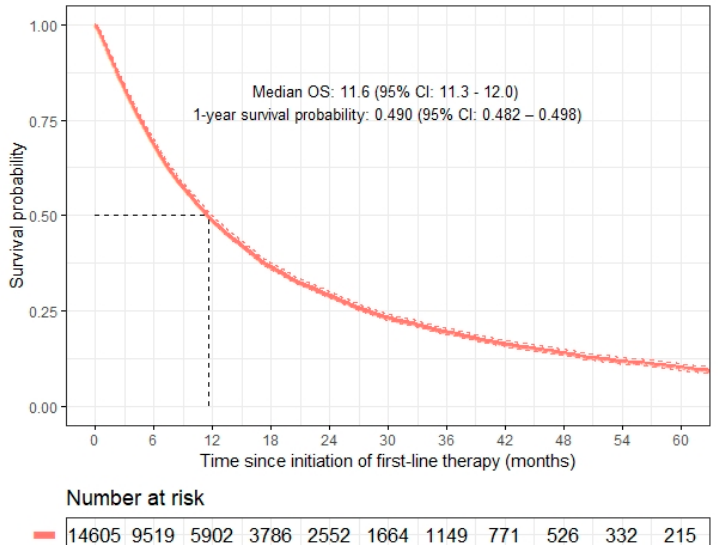
Figure 1. Kaplan-Meier estimates of overall survival for the advanced NSCLC